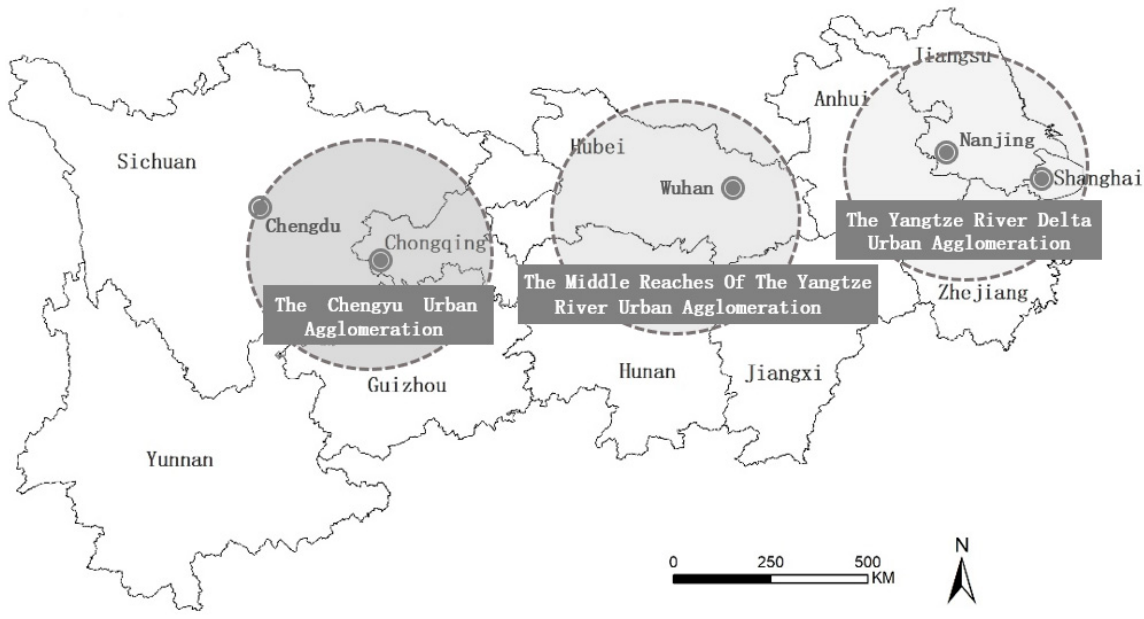
Figure 1. The map of the study area.